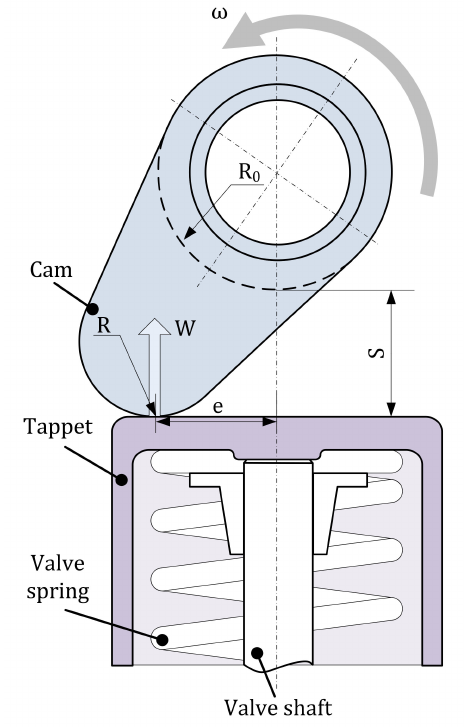
Figure 1. Schematic diagram of a cam / tappet pair in the valve